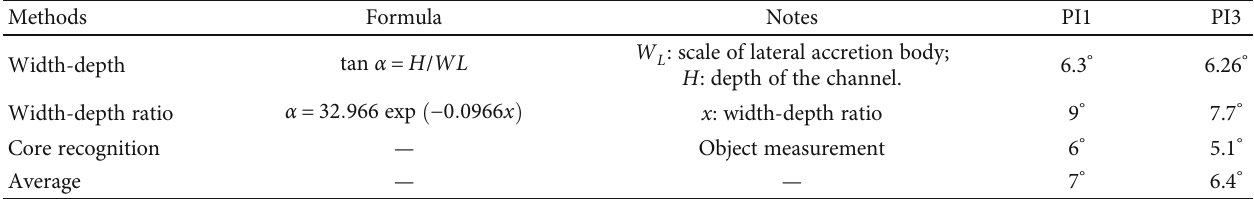
Figure 5: (a) Plan view of the channel width in the PI3 layer. (b) Pro fi le of the channel width in the PI3 layer. Table 3: Method for calculating the dip angle of the lateral accretion interlayer.